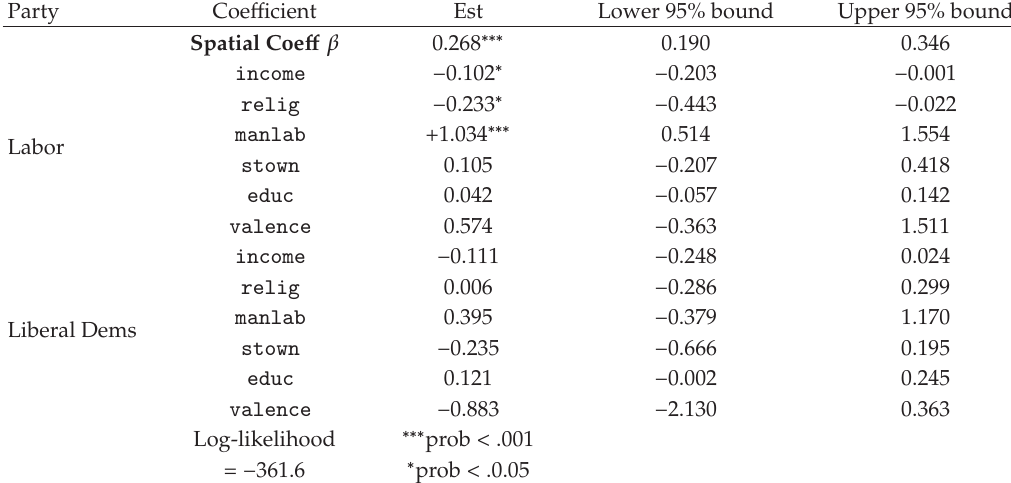
Table 11: British Joint model in 1979 normalized with respect to the conservative